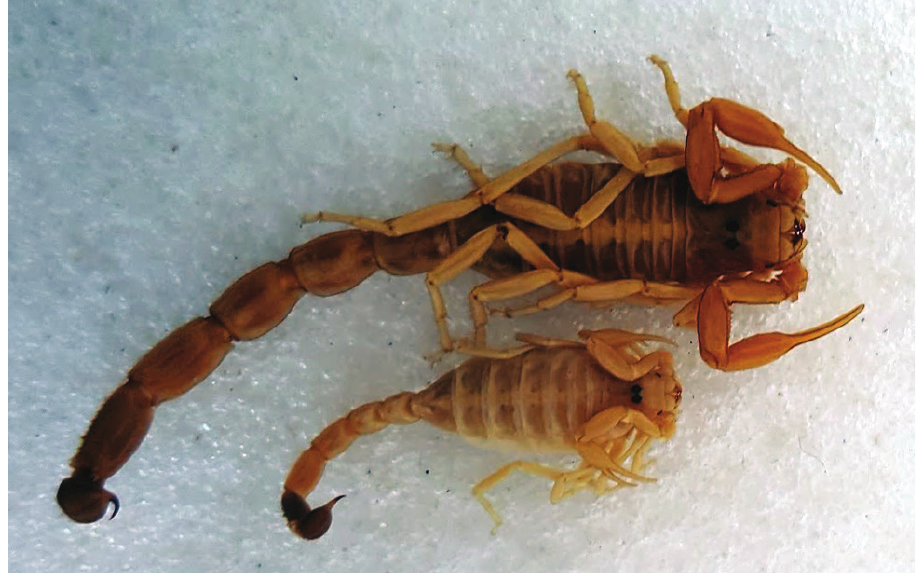
Figure 14. Photo of the syntypes of B. nigrovesiculosus (NHMUK). Photo by Sérgio Henriques.